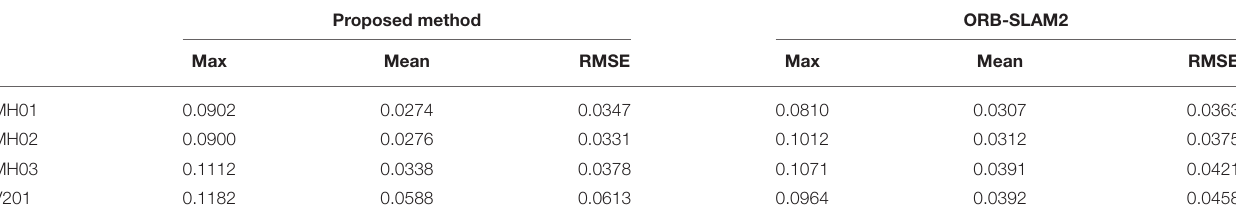
TABLE 2 | Keyframe trajectory accuracy